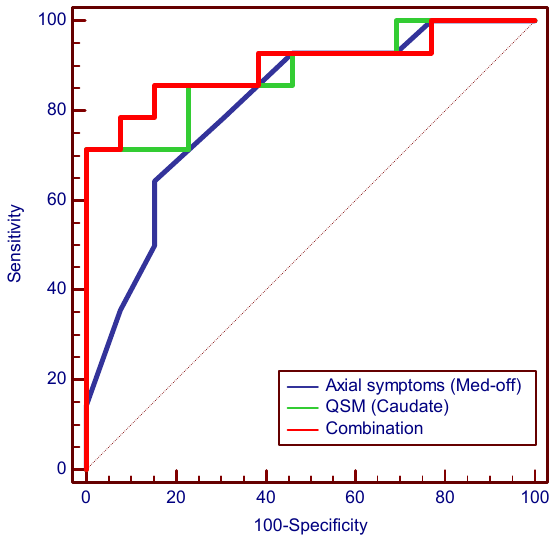
Figure 3. ROC curves for separating the different PSDXb levels of significant features. The combination in the figure indicates the prediction probability of a binary logistic regression model combining axial symptoms (med-off) and the average QSM value in the caudate for the PSDXb levels. PSDXb = the ratio of the power spectral density of beta oscillations to that of the LFP signals, QSM = quantitative susceptibility mapping.